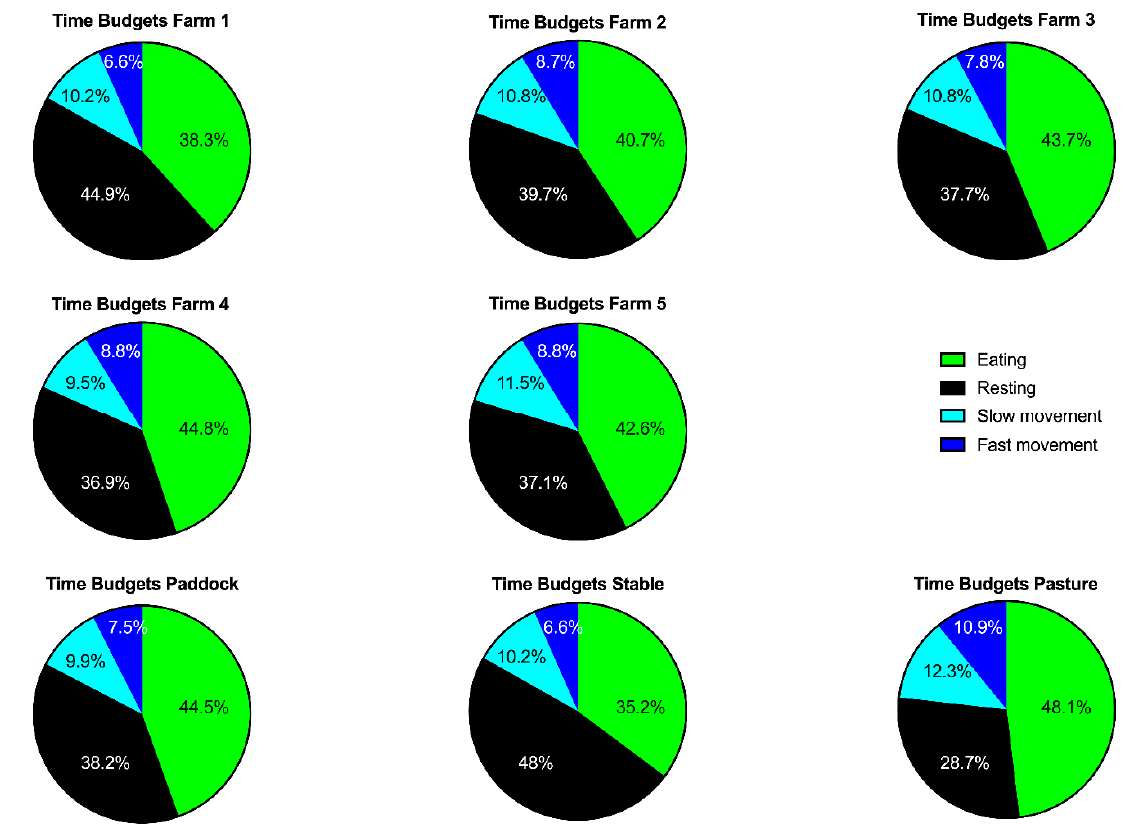
Figure 5. Pie charts illustrating the distribution of the time budgets by farm and turn-out condition.